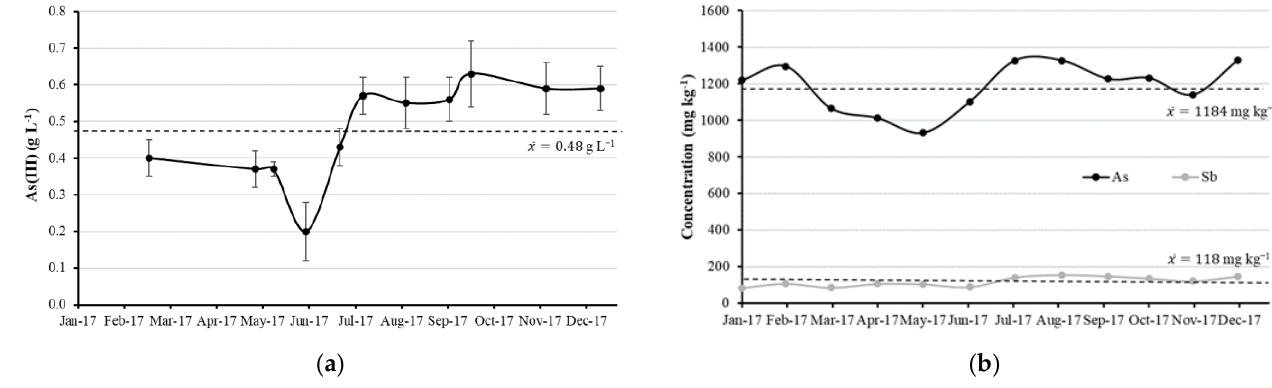
Figure 4. ( a ) Concentration of As(III) in copper electrolyte during the year 2017. The dashed line corresponds to the mean annual concentration; ( b ) Concentrations of As and Sb in anodes for